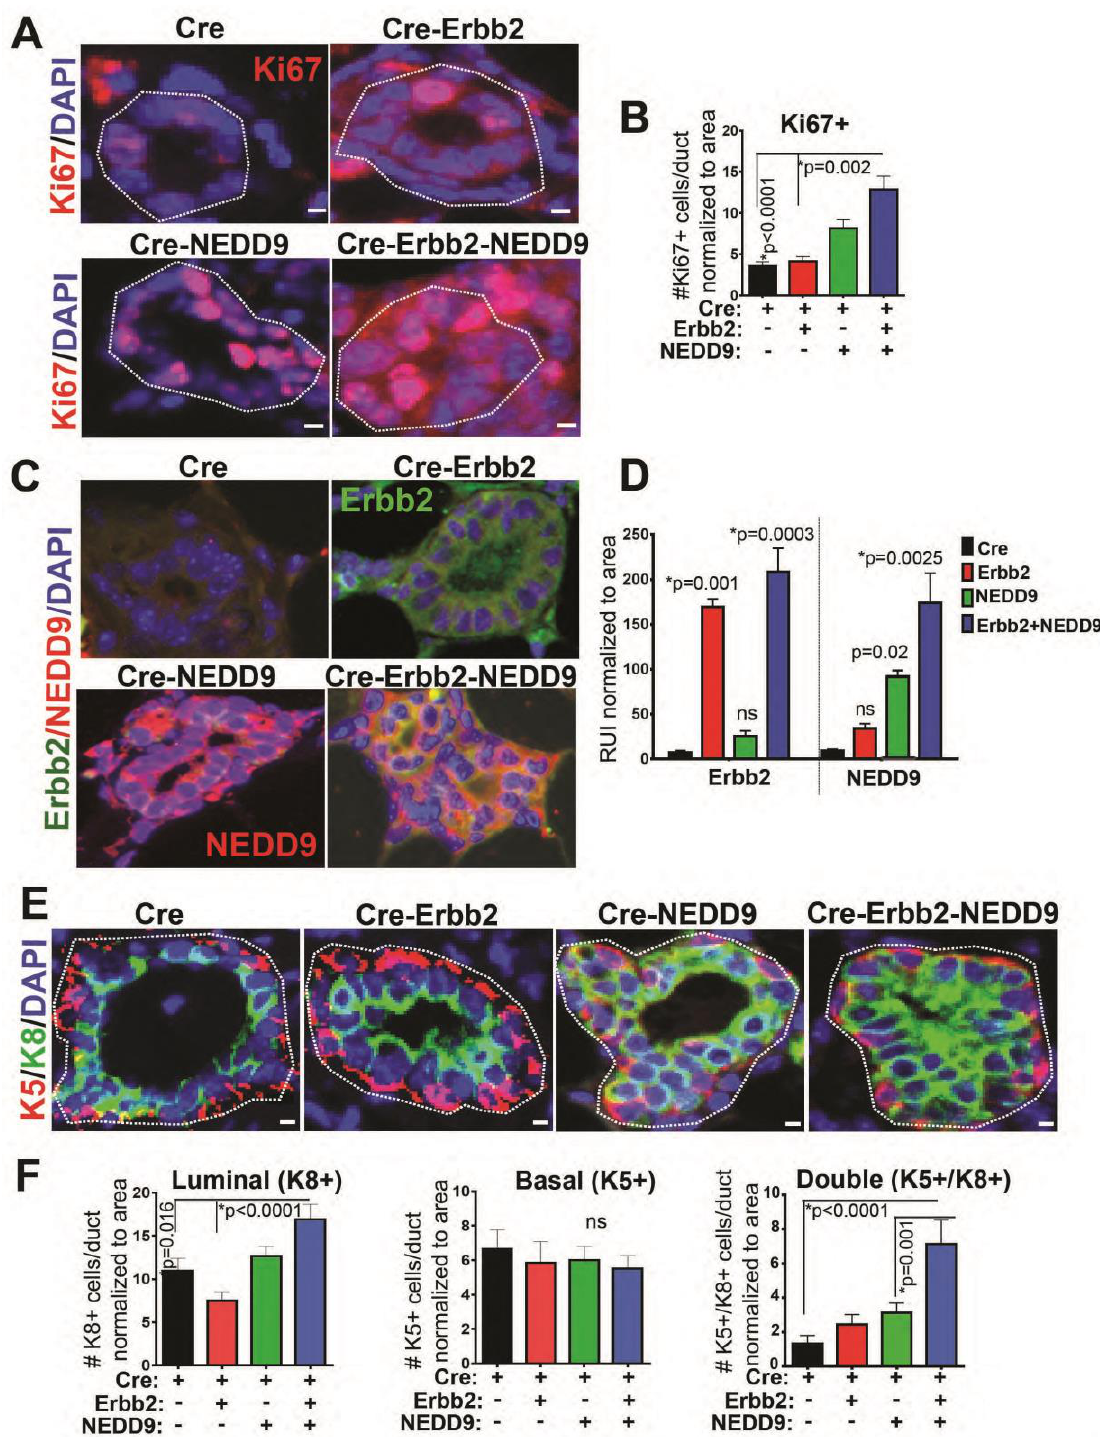
Figure 5. NEDD9 overexpression increases proliferation of luminal cells. ( A ) Representative mam- mary gland images (3D confocal projections, cropped from whole mammary gland scanned) from n = 3–6 mice per genotypes, as indicated in the figure. Fluorescent-IHC staining with anti-Ki67 (red) and DAPI—nuclei (blue). Scale bar—5 mm. ( B ) Quantification of number of positive cells/duct nor- malized to area (n = 5 ducts/mouse, n = 5 per genotype). Data presented as mean ± S.E.M. p -value, indicated in figure panels. One-way ANOVA, Tukey’s multiple comparisons: Cre vs. Cre-Erbb2 is non-significant (ns); Cre vs. Cre-NEDD9 is p = 0.009; Cre vs. Cre-Erbb2-NEDD9 is * p < 0.0001; Cre-Erbb2 vs. Cre-NEDD9 is * p = 0.0002, or vs. Cre-Erbb2-NEDD9 is * p < 0.0001; Cre-NEDD9 vs. Cre-Erbb2-NEDD9 is * p = 0.05. ( C ) Representative mammary gland images. Fluorescent-IHC staining